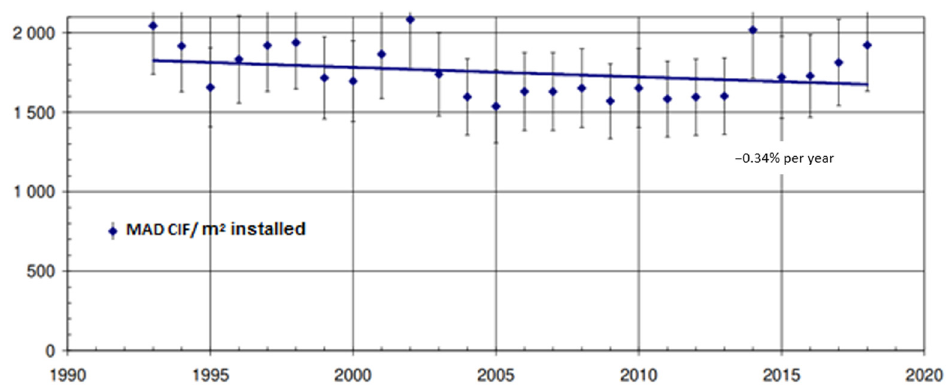
Figure 3. Evolution of the unit wholesale price of thermal collectors (MAD per m 2 ) [42].